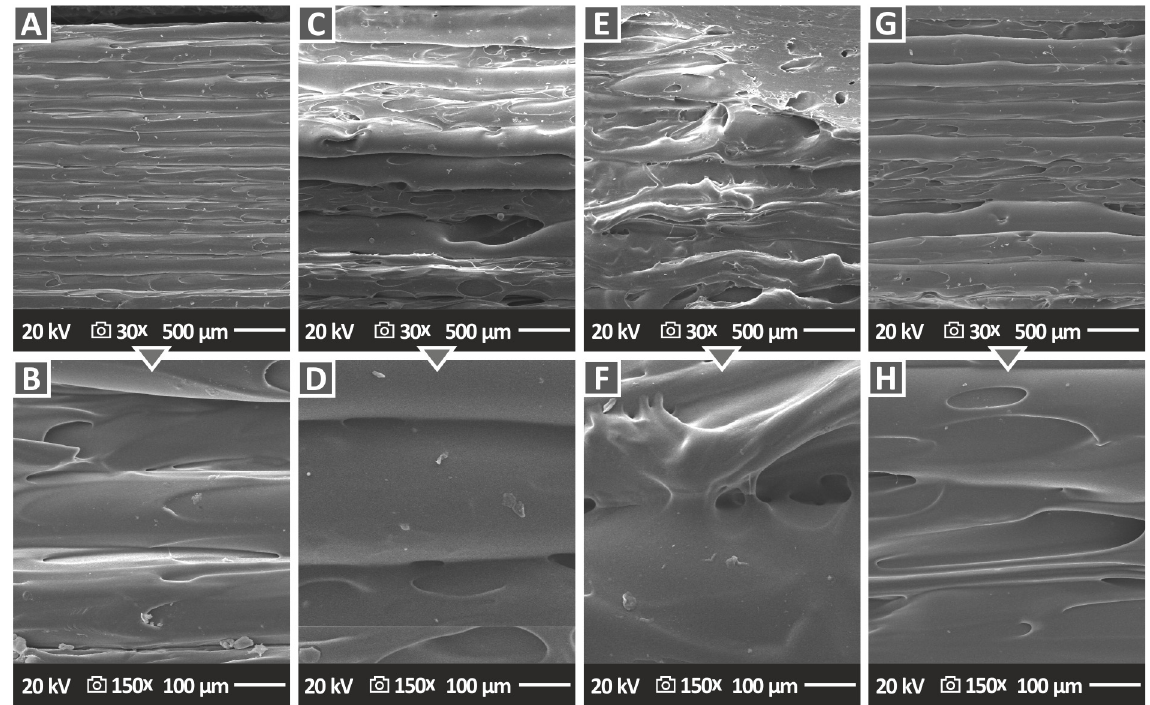
Figure 10. SEM images of the side surface morphology of ( A , B ) PA12/Al 2 O 3 (1.0 wt.%), ( C , D ) PA12/Al 2 O 3 (2.0 wt.%), ( E , F ) PA12/Al 2 O 3 (3.0 wt.%), and ( G , H ) PA12/Al 2 O 3 (4.0 wt.%).